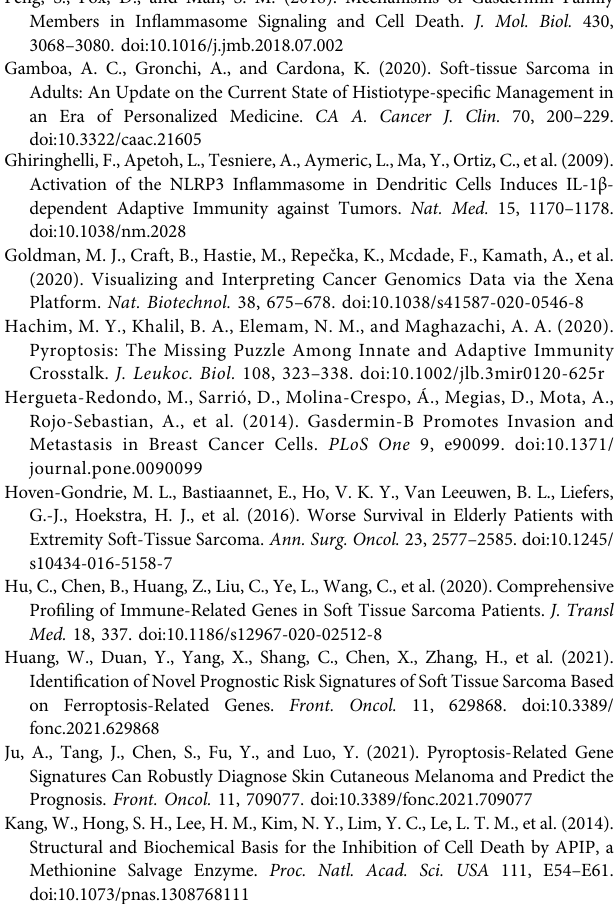
Supplementary Figure S1 | Expression and association of PRGs. A The heatmap of PRGs between STS and normal tissues (*p < 0.05, **p < 0.01, ***p < 0.001, ****p < 0.0001). B and C The correlation network of PRGs. Supplementary Figure S2 | Consensus clustering of TCGA-SARC cohort based on PRGs. A-D Consensus clustering based on PRGs (k (cid:1) 3-6). E Consensus cumulative distribution function (CDF) Plot based on PRGs. F Delta area plot of consensus clustering based on PRGs. Supplementary Figure S3 | Identi fi cation of low-risk and high-risk group based on risk score. A The survival status of TCGA-SARC cohort based on the risk score (low-risk group: left-hand side of vertical dotted line, high-risk group: right- hand side of vertical dotted line). B The survival status of GSE30929 cohort based on the risk score. C PCA for TCGA-SARC cohort based on the risk score. D PCA for GSE30929 cohort based on the risk score. E t-SNE for TCGA-SARC cohort based on the risk score. F t-SNE for GSE30929 cohort based on the risk score. Supplementary Figure S4 | The correlation of prognostic DEGs of the gene signature and immune in fi ltration. The correlation between the abundance of immune cells and the expression of A CTSG, B DUSP9, C CLEC10A, D CPA3, ECD1C in TCGA-SARC